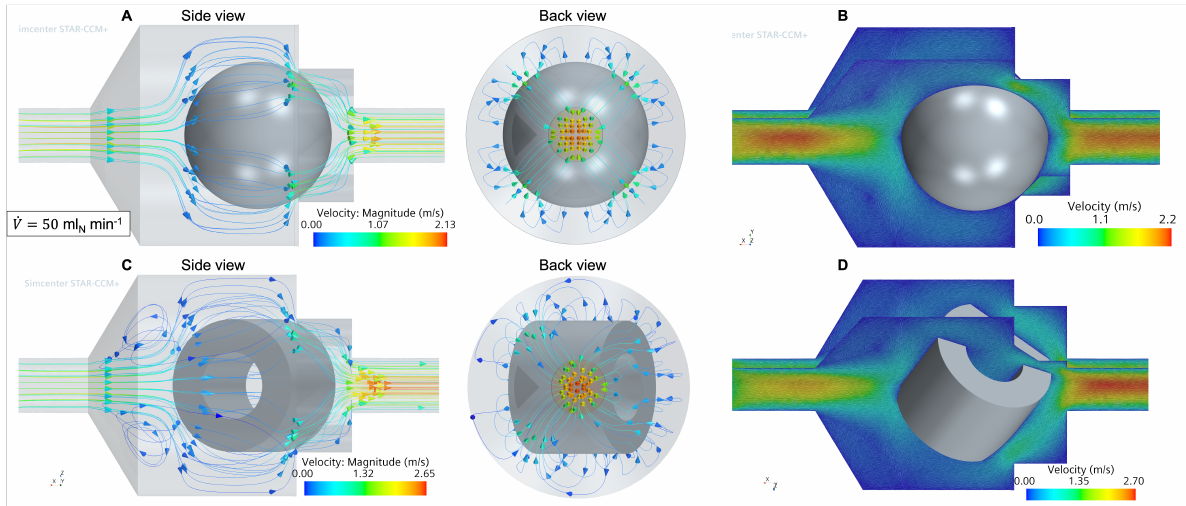
Figure 3. ( A , C ) streamlines and ( B , D ) velocity vector scene for sphere ( top ) and ring ( bottom ) catalyst pellet at ˙ V = 50 ml N min − 1